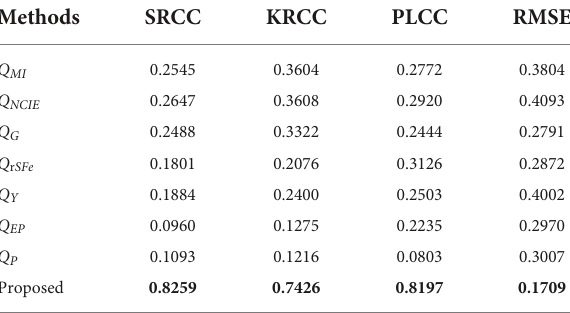
TABLE 1 Comparison of quality assessment performance of different